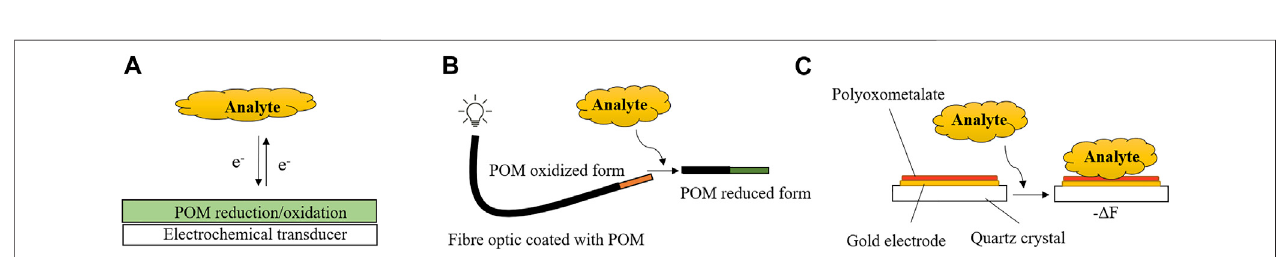
FIGURE 4 | Schematic overview of the most common operation principle of a POM-based electrochemical sensor (A) , POM-based fi bre optic sensor (B) and POM-based mass sensor (C) .